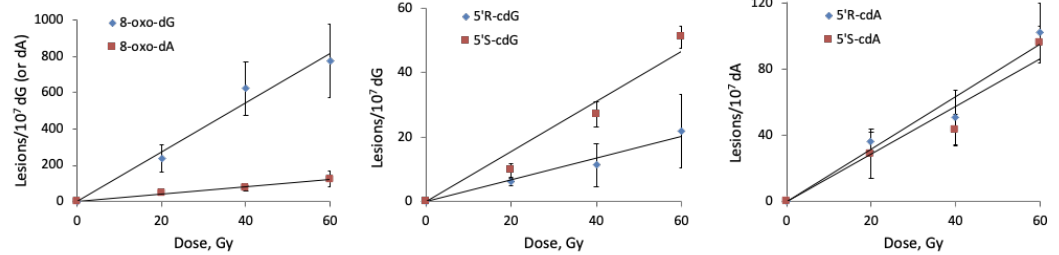
Figure 10. Radiation induced formation of 8-oxo- dG, 5′ S -cdG, 5′ R -cdG, 8-oxo- dA, 5′ S -cdA and 5′ R - cdA in double-stranded 21-mer oligonucleotides; Each sample was exposed to 0, 20, 40 and 60 Gy dose in N 2 O-saturated aqueous solutions. The values represent the mean ± SD of n = 3 independent experiments .